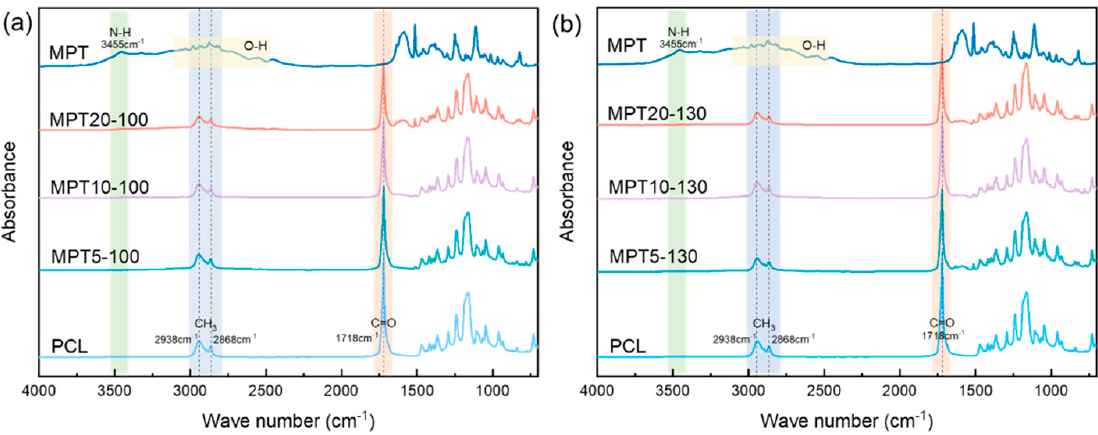
Figure 2. FTIR spectra of PCL/MPT blends with different processing temperatures: ( a ) 100 °C and ( b ) 130 °C.